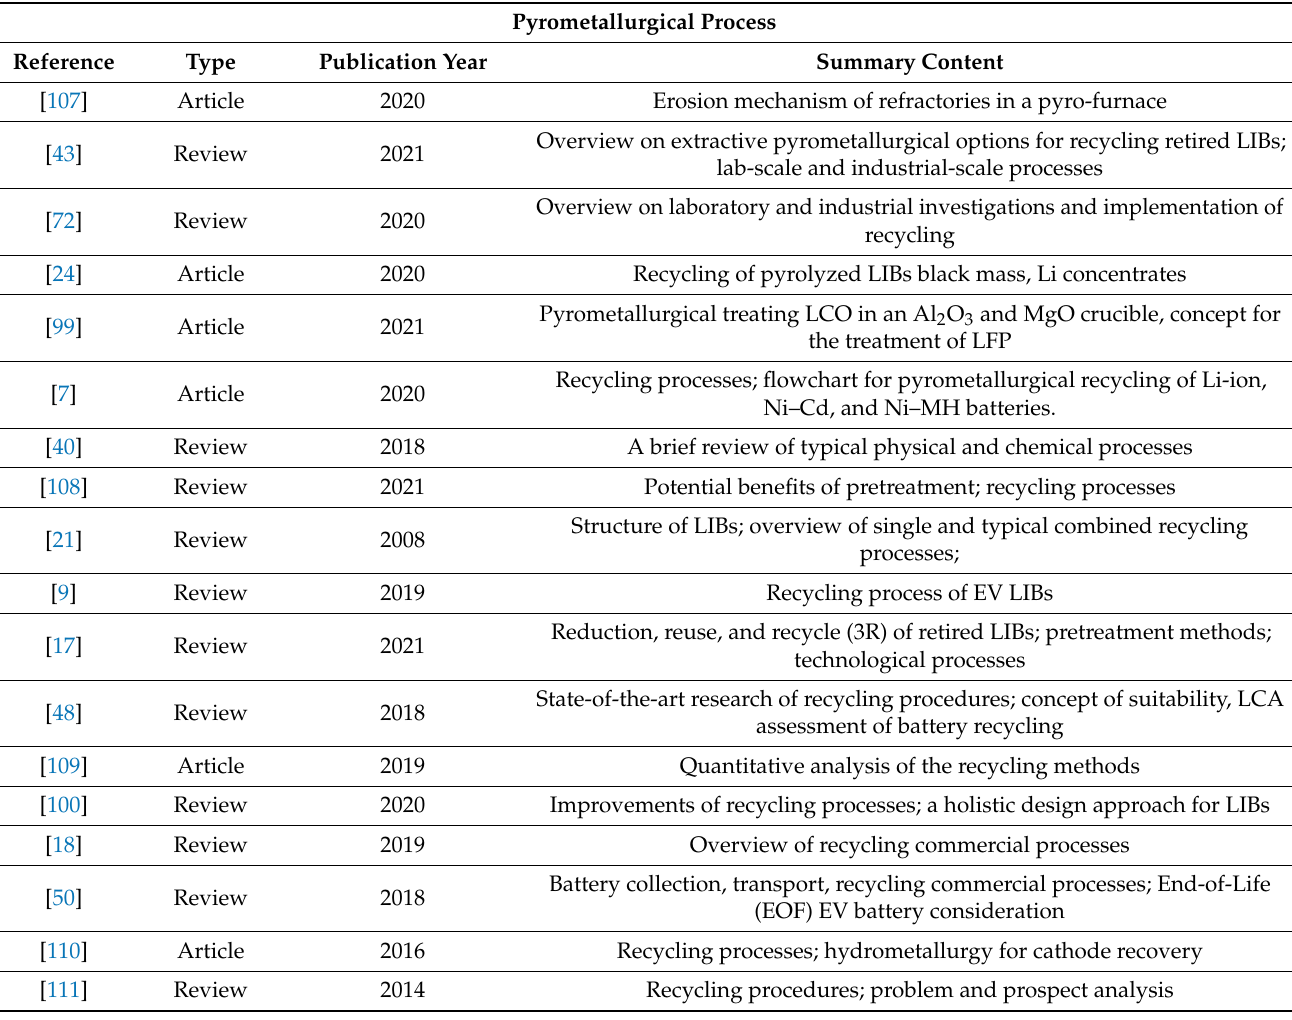
Table A3. Assessed literature in review for “Pyrometallurgical Process”